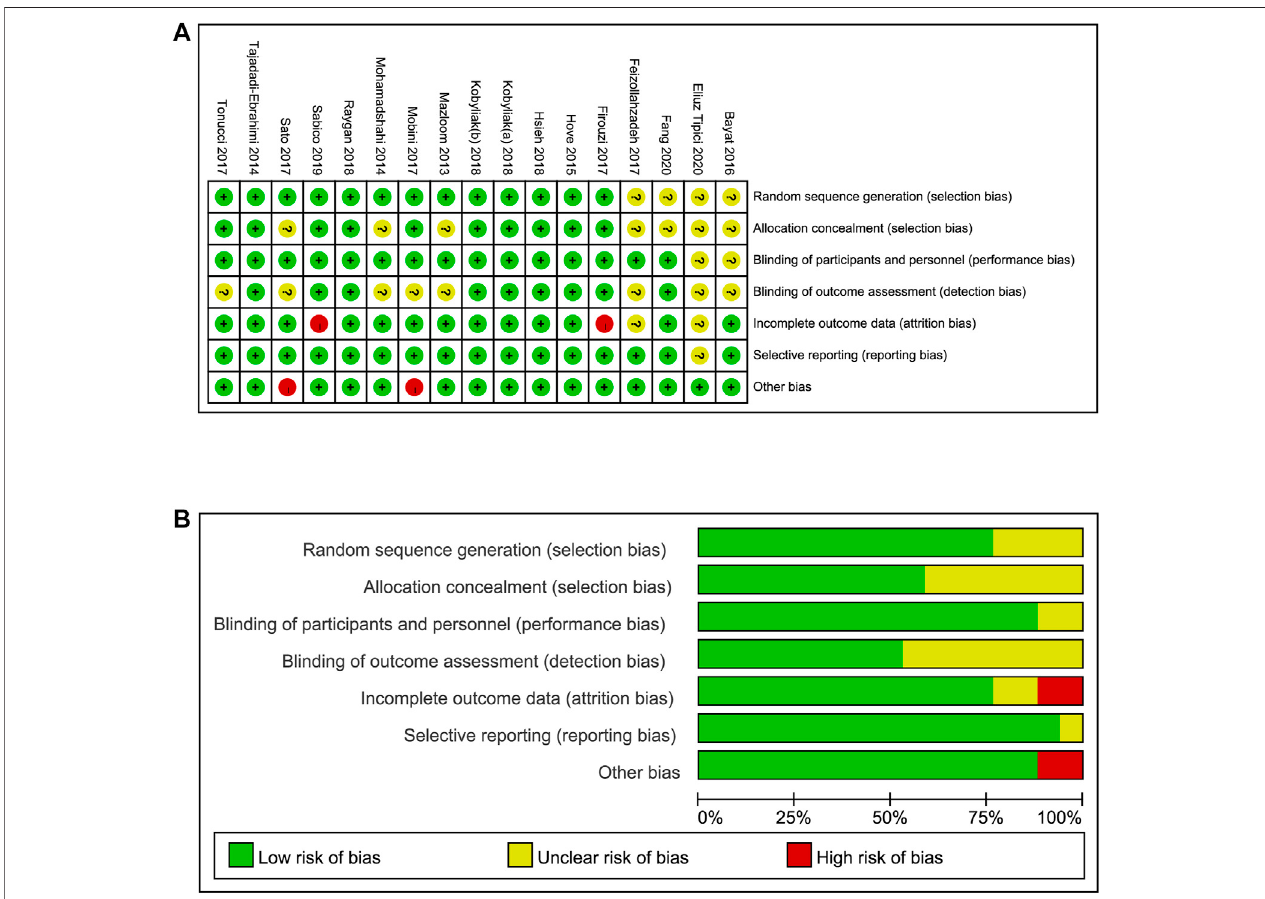
FIGURE 3 | Risk of bias assessment (A) details of included studies, (B) overall